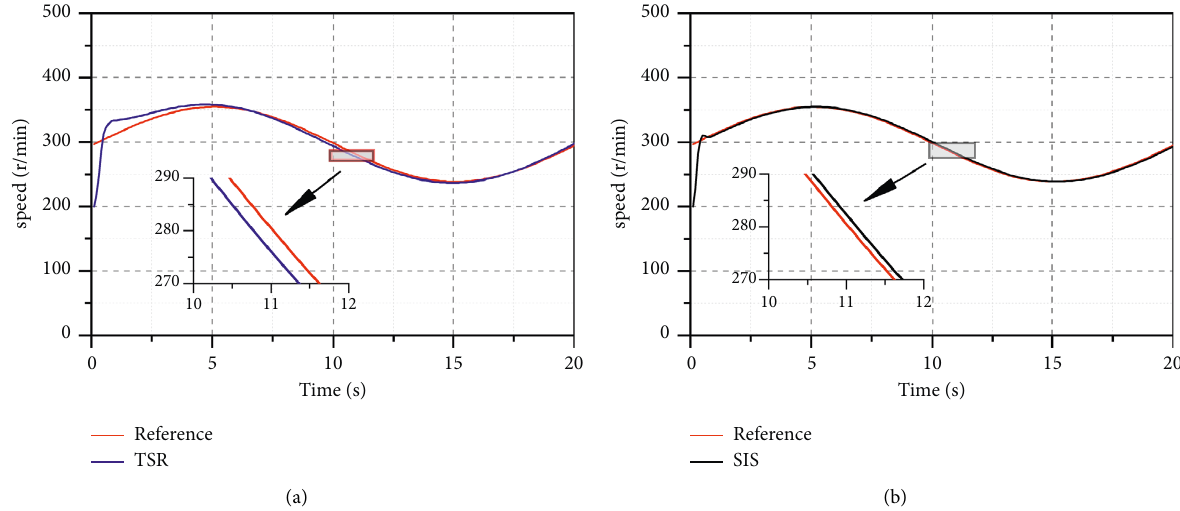
Figure 22: Experimental speed response: (a) speed response based on TSR method and (b) speed response based on the SIS